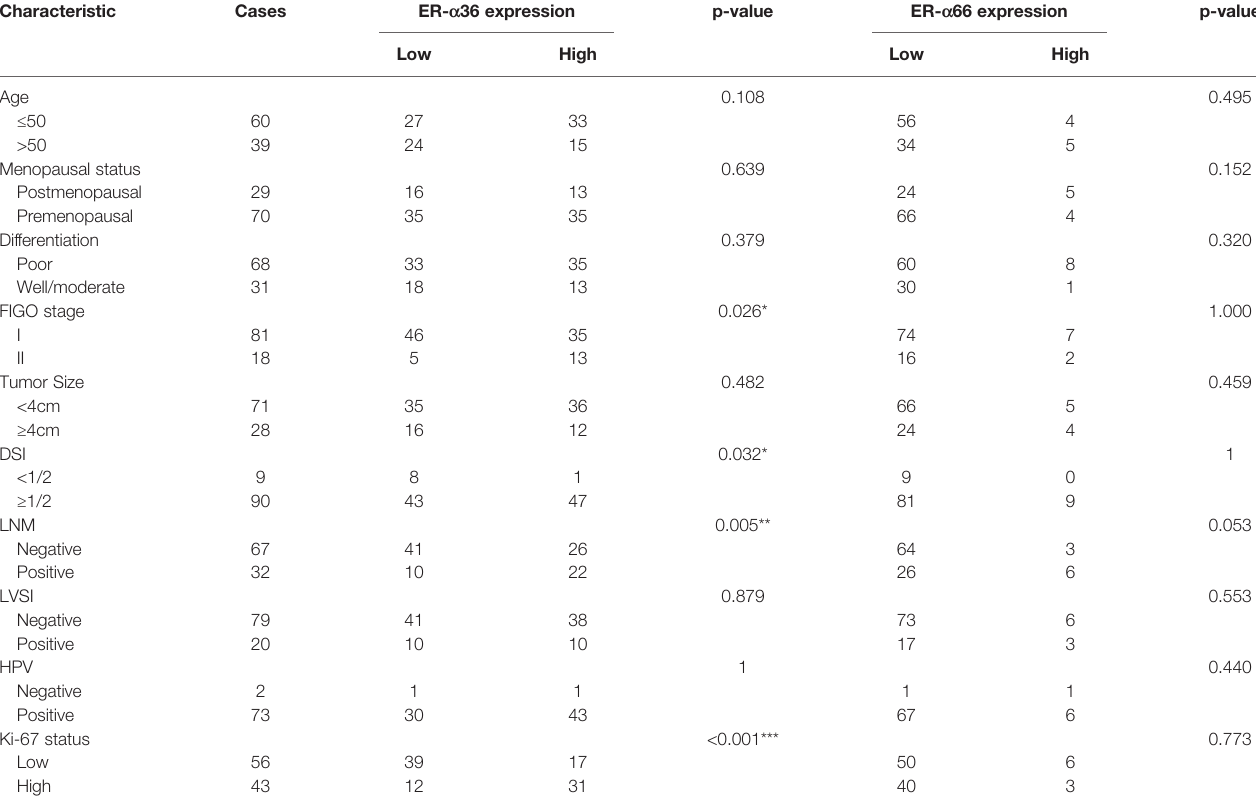
TABLE 1 | Association between ER- a 36/ER- a 66 expression and clinicopathologic characteristics of cervical SCC patients.